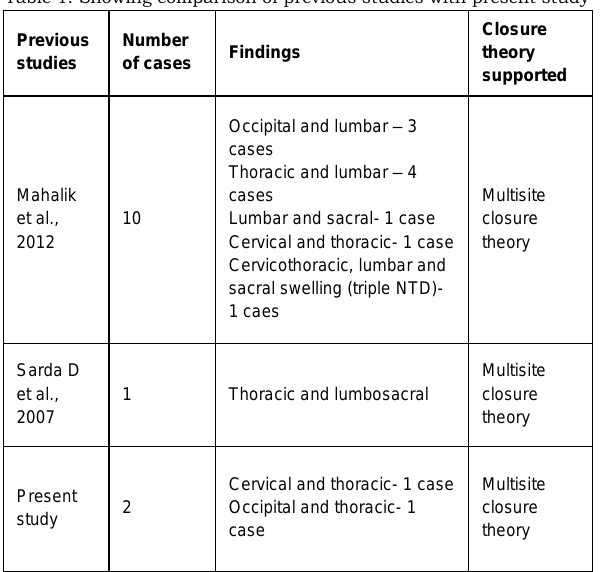
Table 1: Showing comparison of previous studies with present